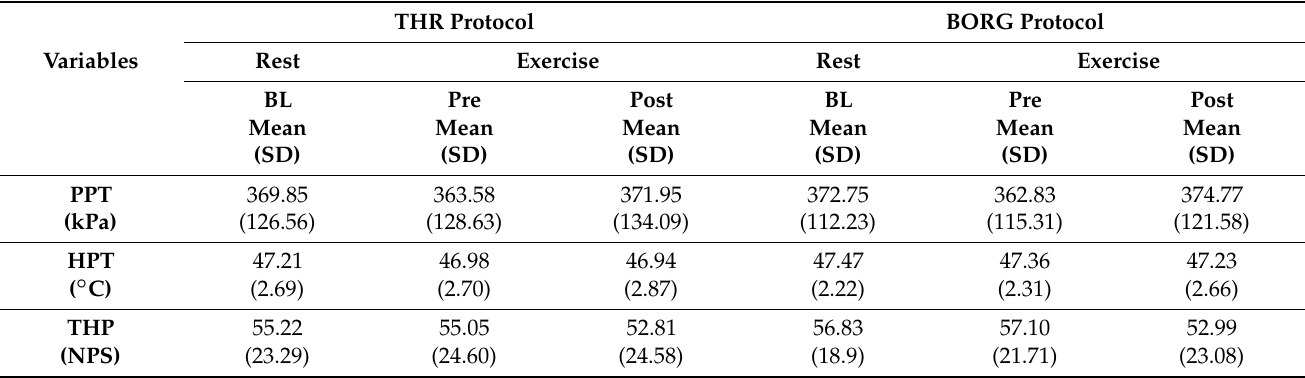
control intensity